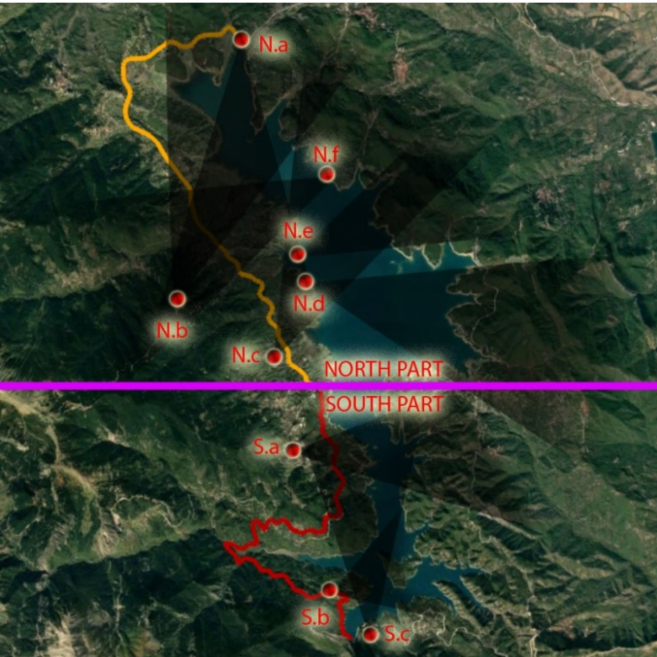
Figure 6. Purple line: theoretical line that separates the north and south part of the landscape; yellow and red lines: main peripheral reservoir roads; red dots and shadowed cones: positions of pictures and direction of views of the landscape (Figures 7–9).